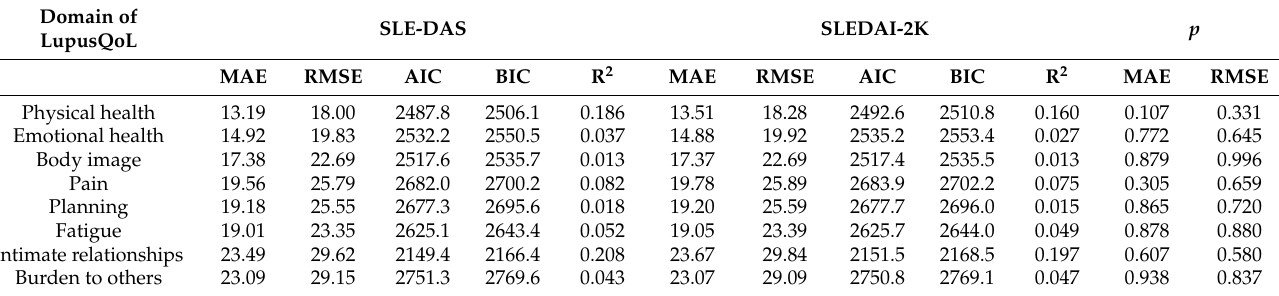
Table 7. Regression model accuracy metrics of the eight domains of Lupus Quality of Life (LupusQoL) with Systemic Lupus Erythematosus Disease Activity Score (SLE-DAS) and Systemic Lupus Erythematosus Disease Activity Index 2000 (SLEDAI-2K) adjusted for age and sex SLE patients without renal involvement ( N = 286). Domain of